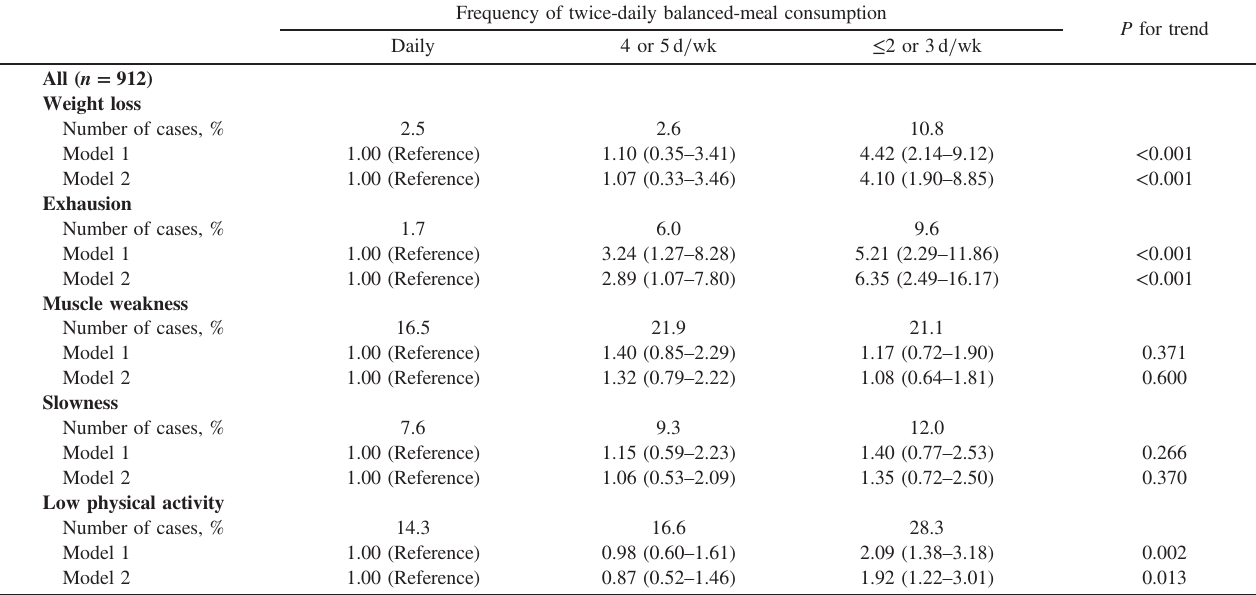
Model 1 was adjusted for sex, age, and study site. Model 2 was adjusted for variables in Model 1 plus education, living alone, smoking and drinking habits, body mass index, self-perceived chewing ability, and medical history (hypertension, hyperlipidemia, diabetes, cancer, stroke, heart disease, arthritis, and chronic obstructive pulmonary disease). Table 3. Odds ratios and 95% con fi dence intervals for associations of frequency of twice-daily balanced-meal consumption with frailty components Frequency of twice-daily balanced-meal